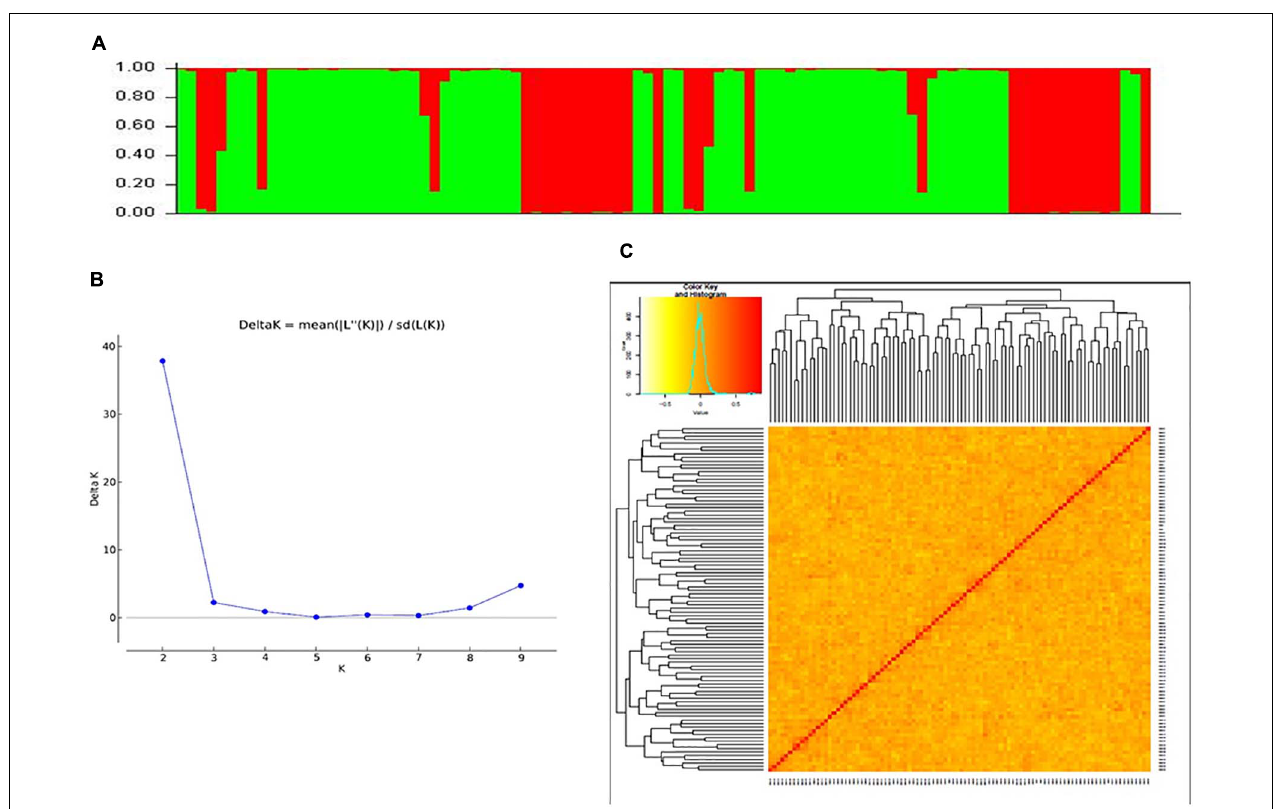
FIGURE 3 | (A) Bar graph for population structure of cotton genotypes performed by admixture method in STRUCTURE, which grouped all accessions into two clusters. (B) Estimation of number of clusters using (cid:49) K values for K ranging from 2 to 10. (C) Heat map plot displaying relationships of 96 cotton genotypes based on SSR markers.